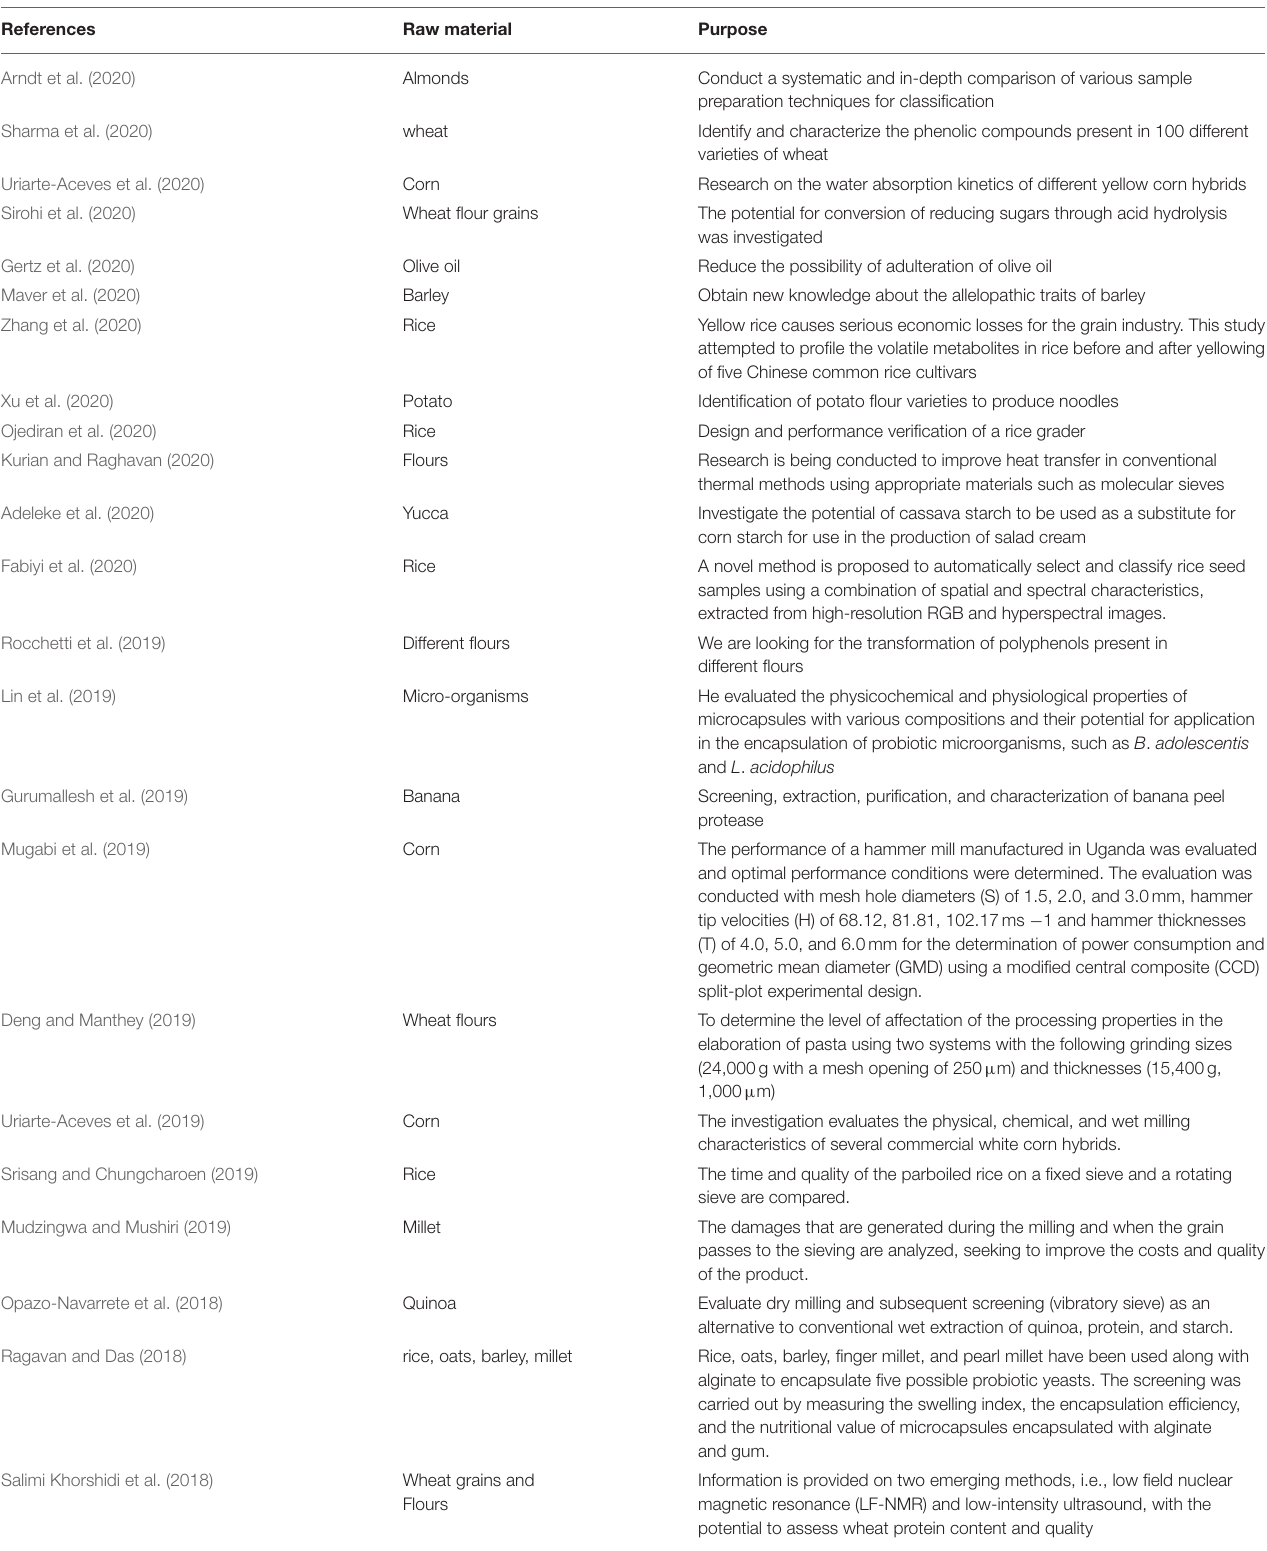
TABLE 3 | Raw materials subjected to a